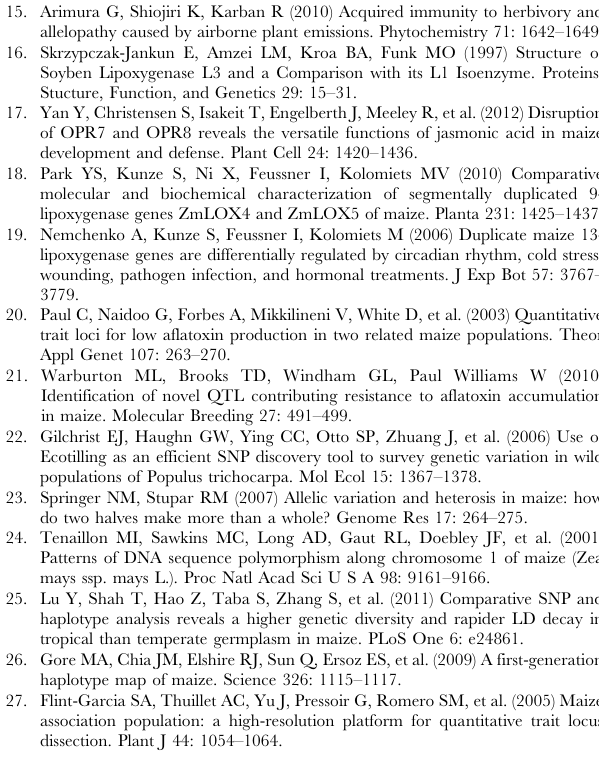
Table S1 SNP genotypes for the 260 lines successfully sequenced for ZmLOX4 and their respective position on